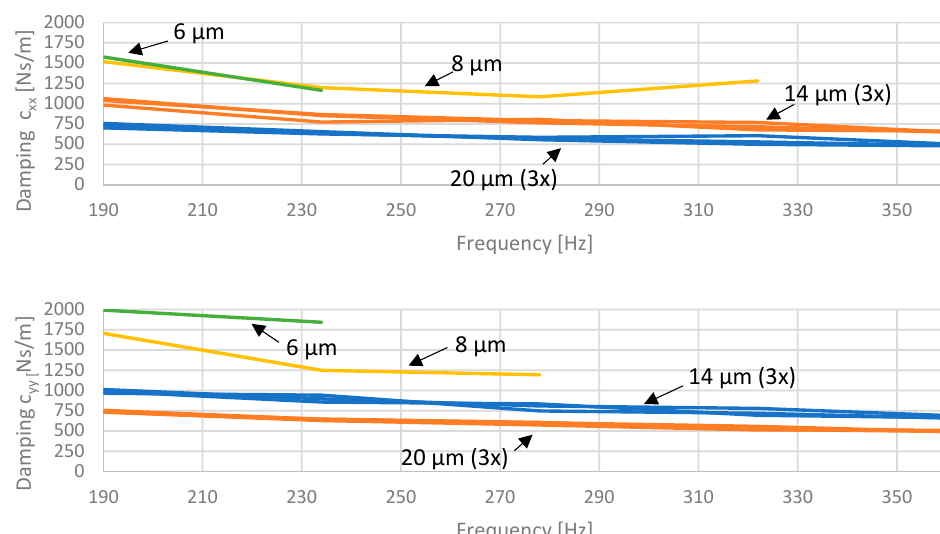
Figure 13. Influence of different displacement amplitudes on direct stiffness coefficients at 11.1 N static load; tests with 6 µm and 8 µm were stopped due to poor control behavior (highly non-linear); repeated measurements (3 times) including new controlling sequences (see error discussion of controller).